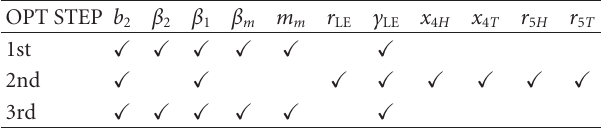
Table 2: Parameters varied in 3-blade impeller optimization’s steps.